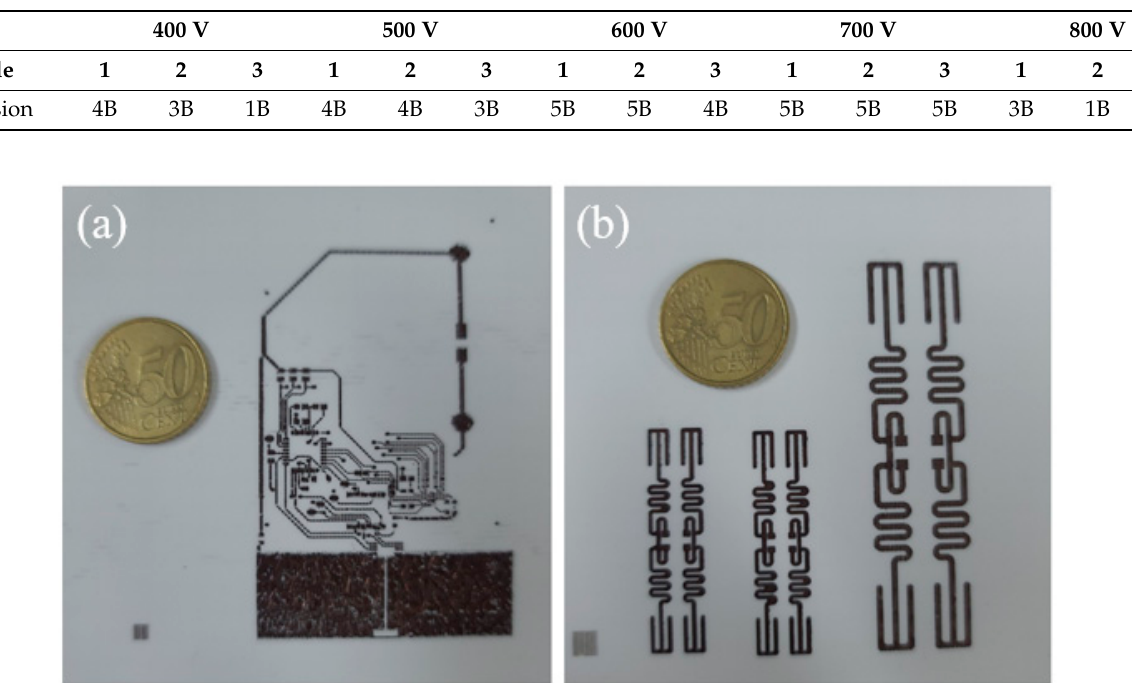
Table 3. Adhesion strength results of the ink-jet printed conducting layer with IPL-sinterable nano Cu ink after IPL sin- tering (ASTM D3359).